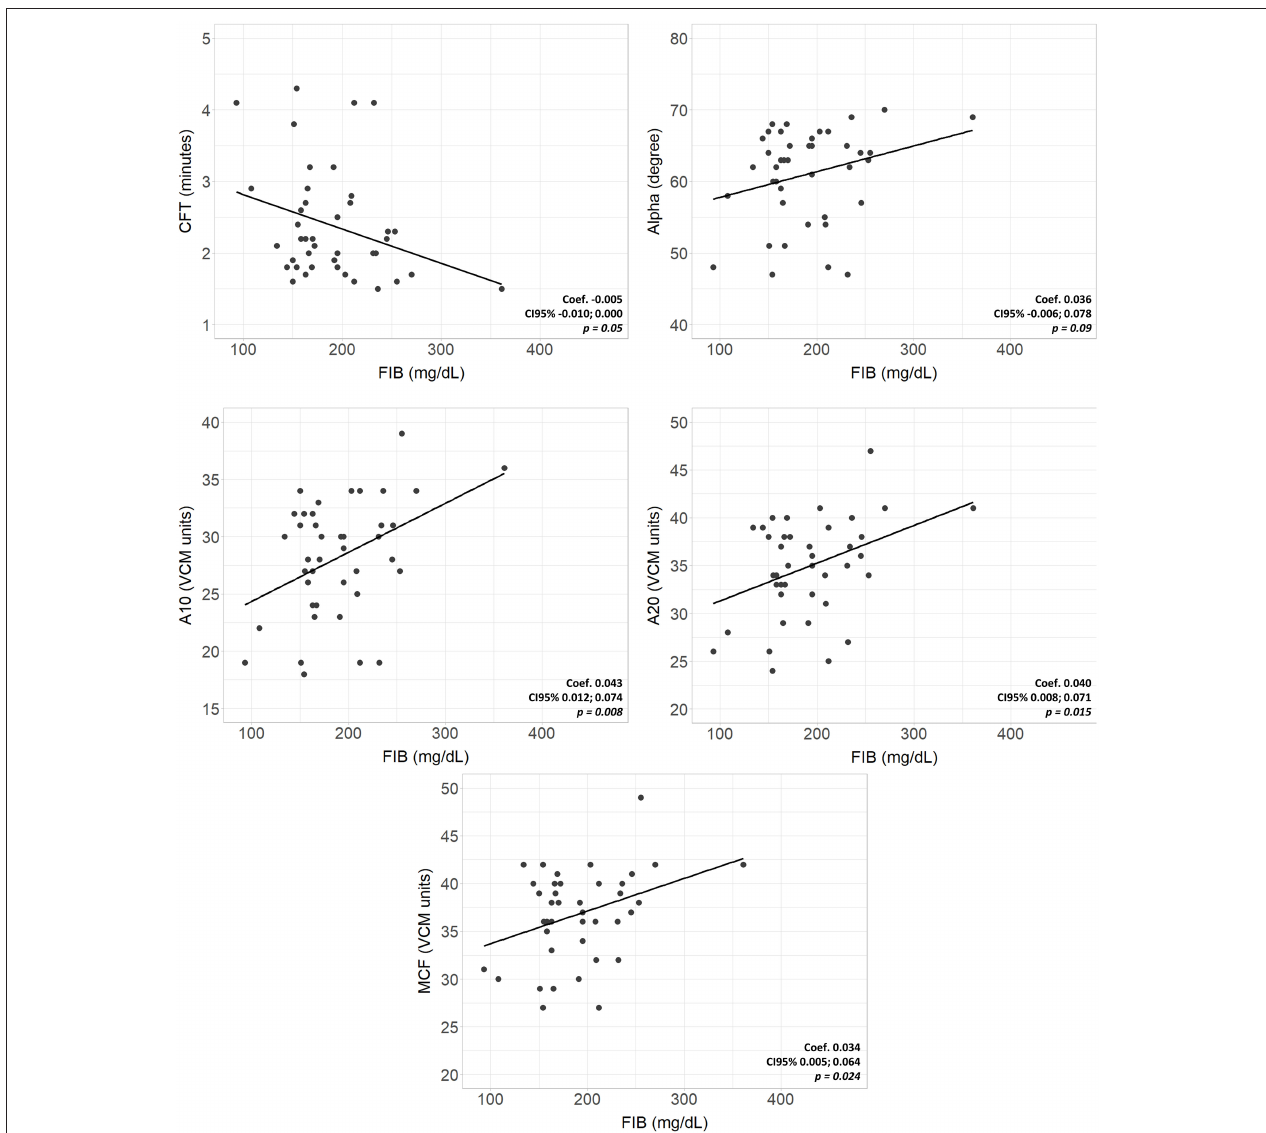
FIGURE 5 | Scatterplots of VCM parameters and corresponding laboratory coagulation parameters: Fibrinogen. Coef, linear regression coefficient; p, p-value; FIB, fibrinogen; CFT, clotting formation time; Alpha, alpha angle; A10, amplitude at 10min; A20 amplitude at 20min; MCF, main clotting